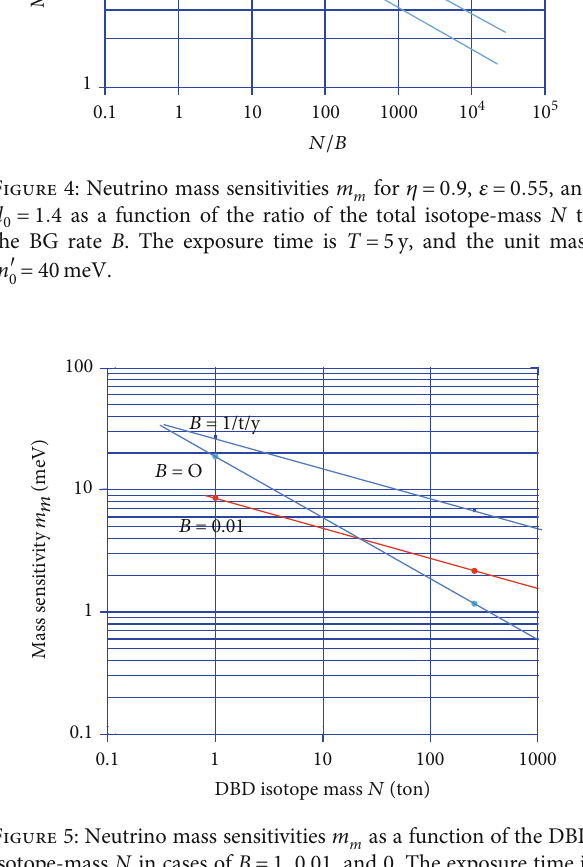
as a function of the DBD m